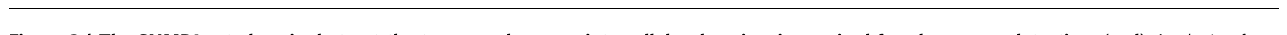
Figure 3 | The SNMP1 ectodomain, but not the transmembrane or intracellular domains, is required for pheromone detection. ( a – d ) Analysis of SNMP1 D N-term , SNMP1 D C-term , NINAD:EGFP (for immunohistochemistry) or untagged NINAD (for electrophysiology) and SNMP1/NINAD:GFP chimera rescue transgenes. Left: immunostaining with a -SNMP1 ( a , b ) or a -GFP ( c , d ) on antennal cryosections. Scale bars, 20 m m. As SNMP1 D C-term lacks the C-terminal peptide epitope of the SNMP1 antibody 16 , we used an antibody raised against an SNMP1 ectodomain peptide; although this antibody recognizes SNMP1 in soma, it does not label cilia-localized SNMP1, even in wild-type flies, precluding direct visualization of SNMP1 D C-term in this sensory compartment. Centre: representative traces of extracellular electrophysiological recordings of OR67d neurons in male flies stimulated with 10% cVA. Right: mean neuronal responses ± s.e.m. in each genotype. There are significant statistical differences in neuronal responses due to genotype for both 1 and 10% cVA (Kruskal–Wallis, P o 0.0001). Significant differences in cVA responses of the different genotypes compared with full-length SNMP1 rescue (Fig. 1) are indicated in the figure; * P o 0.05, *** P o 0.001. ( e ) Schematic representation of SNMP1 in which each amino acid is represented by a circle. Putative N-glycosylation sites are indicated with hexagons and disulfide bonds by dashed grey lines. The 17 ectodomain deletions tested are indicated on the structure in blue or red, representing those that do or do not localize to sensory cilia, respectively. ( f ) Summary of the localization and functional properties of the SNMP1 ectodomain deletion mutants. ( g ) Phenotypes of SNMP1 D 5 and SNMP1 D 13 rescue properties. Left: immunostaining with a -SNMP1 on antennal cryosections. Scale bars, 20 m m. Right: representative traces of electrophysiological recordings of male flies stimulated with 10% cVA.